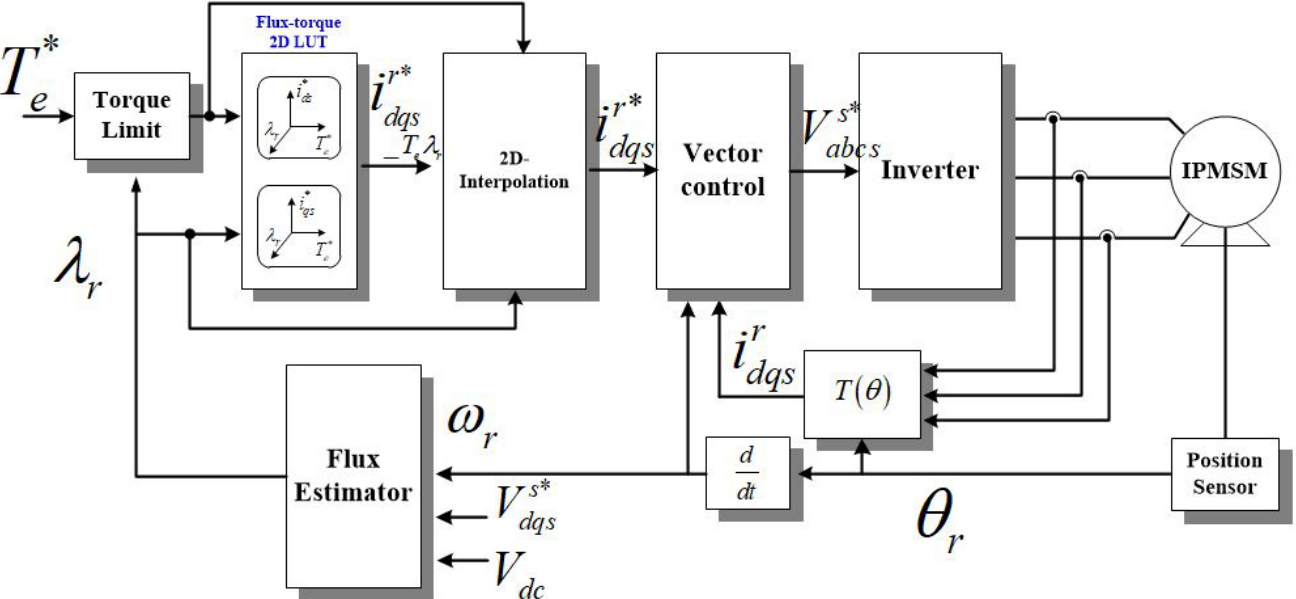
Figure 1. Flux-torque look-up table based PMSM control method [1]. Interior Permanent Magnet Synchronous Motor